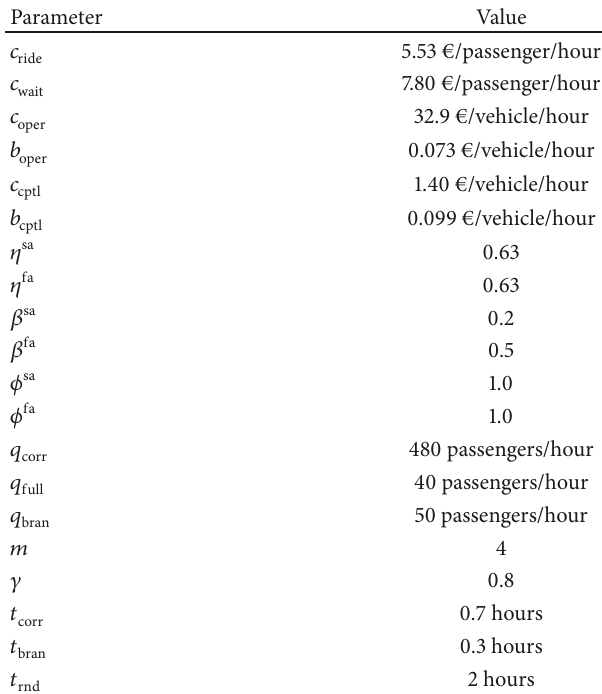
Table 2: Nominal parameter values used in the numerical